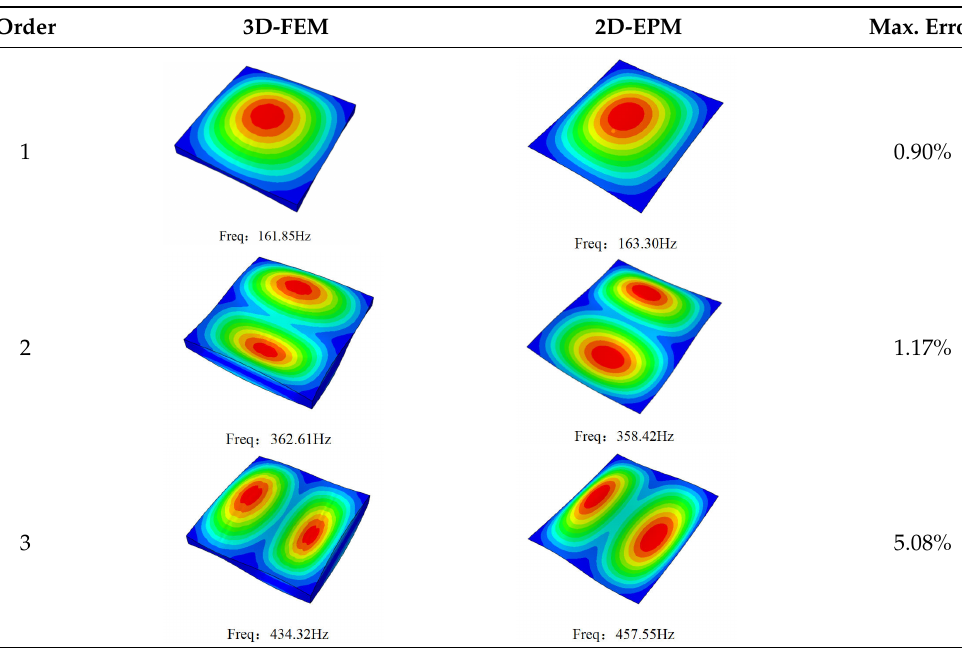
Table 10. Comparison of the first three free vibration characteristics predicted by two models under the boundary condition in Case 4.